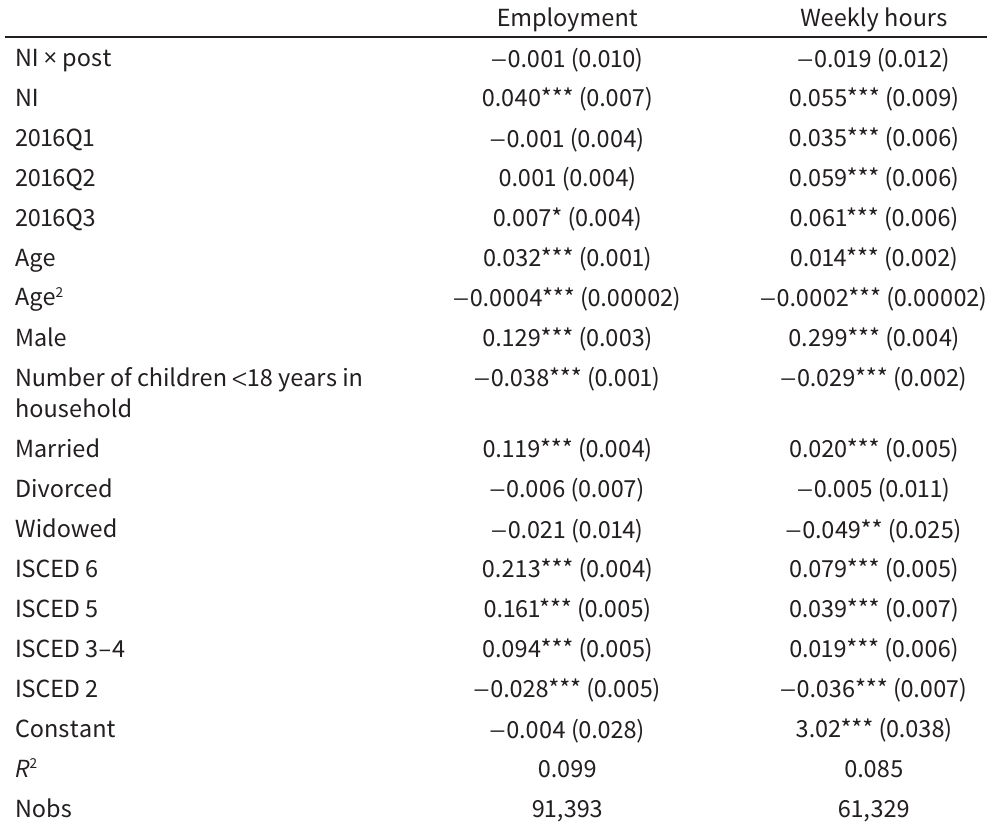
Full difference-in-differences estimates of impacts of the NLW introduction on employment and hours in NI, coefficients (standard errors)